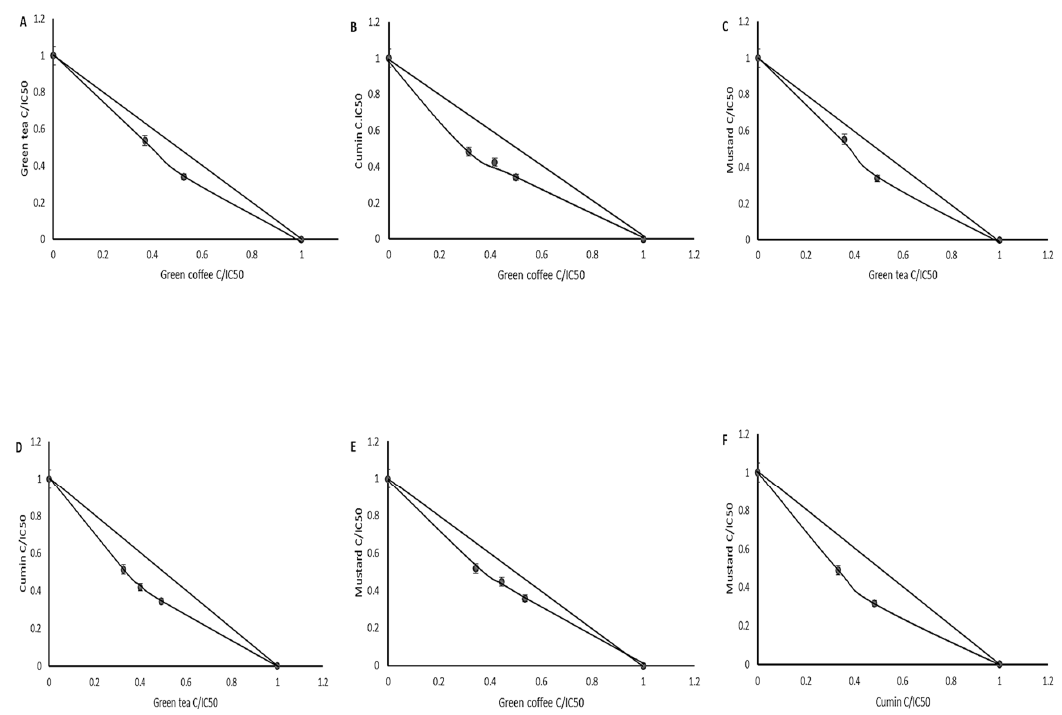
Figure 6. Dose-normalized isobolograms for digested extracts from green tea and green coffee ( A ), cumin and green coffee ( B ), mustard and green tea ( C ), cumin and green tea ( D ), mustard and green coffee( E ), mustard and cumin ( F ) affecting TPO activity.